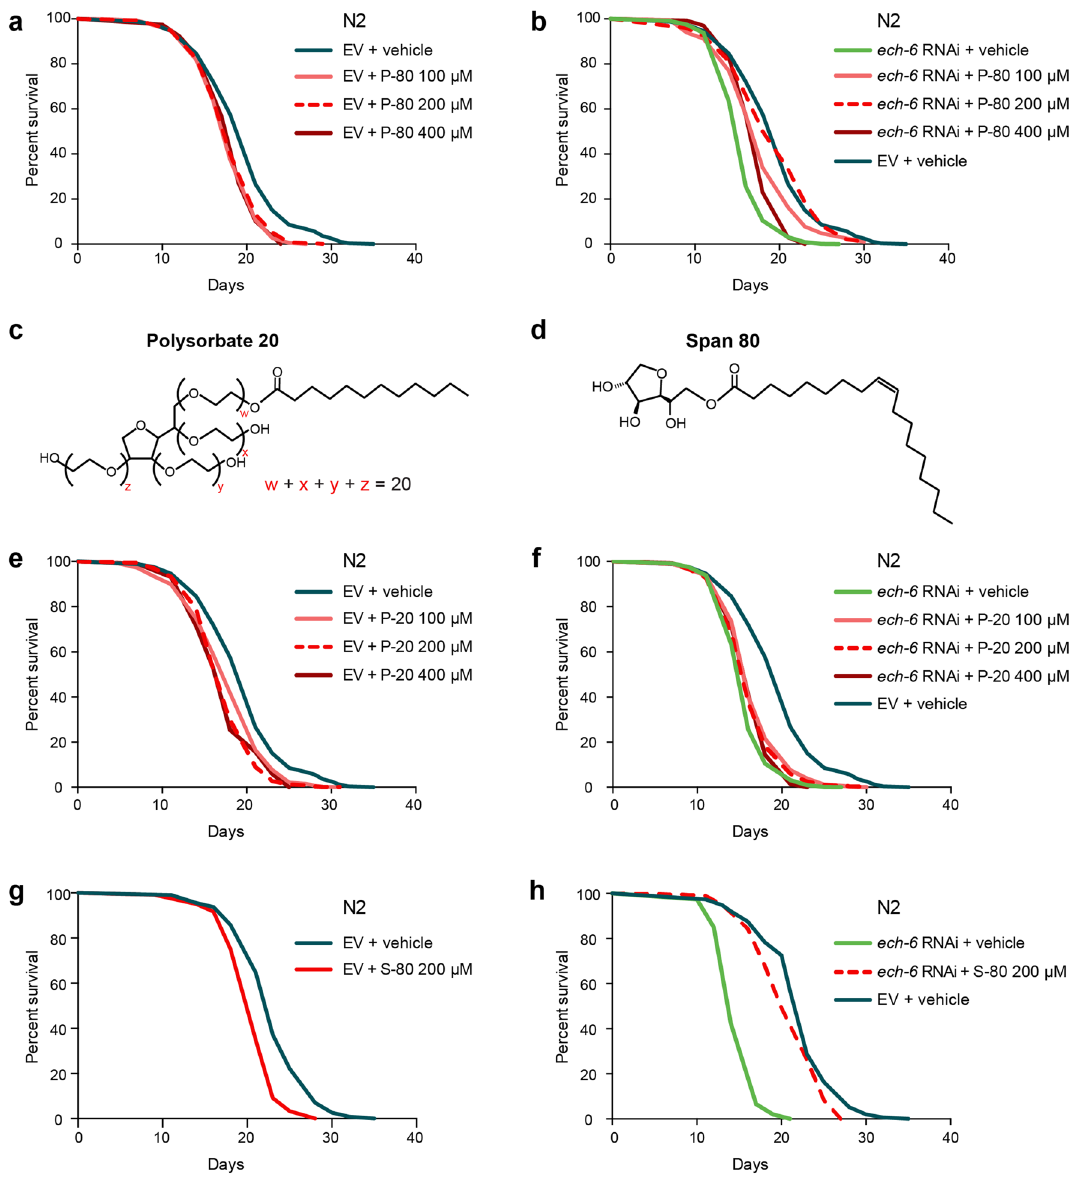
Figure 2. Fat diets affect the lifespan upon ech-6 deficiency in a dose- and oleic acid-dependent fashion. ( a ) Lifespan analysis showing that P-80 supplementation at doses ranging from 100 µM to 400 µM reduces lifespan ( p < 0.0001, log-rank test). ( b ) Lifespan analysis of worms upon ech-6 deficiency showing that feeding ech-6 - deficient worms the P-80 diet at 200 µM results in a maximum restoration of lifespan ( p = 0.564 , comparing ech-6 RNAi + P-80 200 µM to empty vector (EV) + vehicle, log-rank test). ( c ) Chemical structure of Polysorbate 20 (P-20). P-20 consists of a hydrophilic group of ethylene oxide polymers and a lauric acid. ( d ) Chemical structure of Span 80 (S-80). S-80 consists of a sorbitan monoester and an oleic acid. ( e ) Lifespan analysis of worms fed with P-20 showing that worms exposed to the P-20 diet at doses ranging from 100 µM to 400 µM lived significantly shorter ( p < 0.0001, log-rank test). ( f ) Lifespan analysis of worms upon ech-6 deficiency showing that P-20 supplementation at a concentration from 100 to 400 µM does not prevent ech-6 RNAi from shortening lifespan ( p < 0.0001, log-rank test). ( g ) Lifespan analysis of worms fed a S-80 diet showing that S-80 supplementation at 200 µM shortens lifespan ( p < 0.0001, log-rank test). ( h ) Lifespan analysis of worms upon ech-6 deficiency showing that S-80 supplementation at 200 µM protects worms against ech-6 RNAi-induced lifespan decrease ( p < 0.0001, log-rank test). See also Table S1 for lifespan